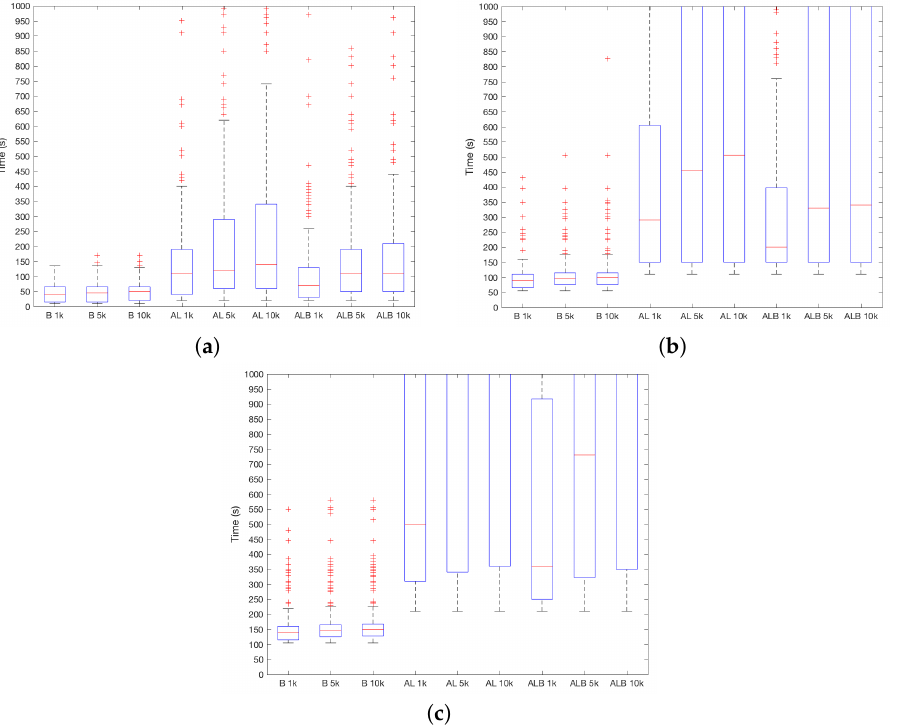
Figure 6. T SEC results depending on the amount of storage required. ( a ) ST = 1; ( b ) ST = 10; ( c ) ST =